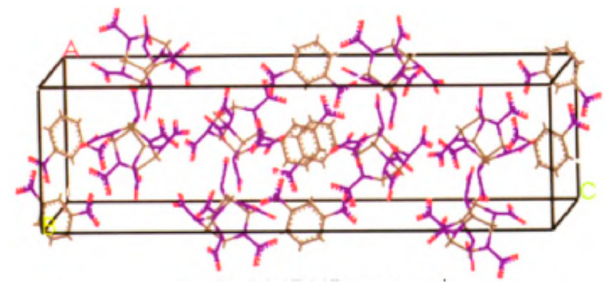
Figure 4. The primitive cell of CL-20/DNB cocrystal [3], with permission from Han Neng Cai Liao, 2015.